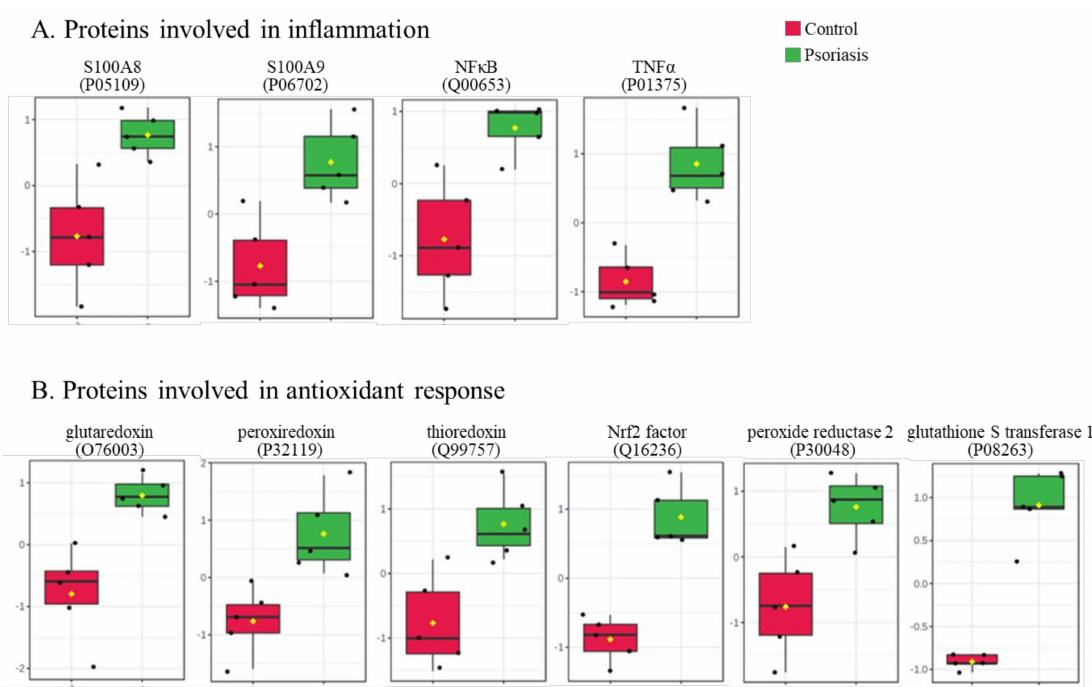
Figure 5. The level of significantly changed proteins involved in the antioxidant response ( A ) and inflammation ( B ) of fibroblasts isolated from skin of psoriatic patients ( n = 5) and healthy controls ( n = 5).